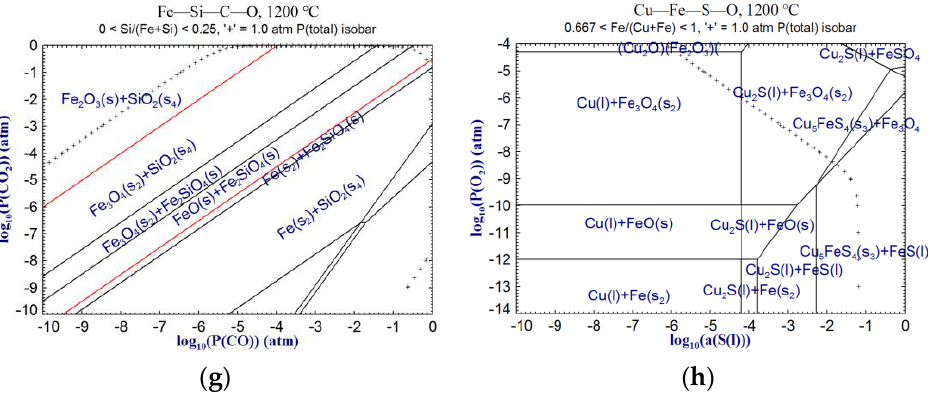
( g ) ( h ) Figure 4. Advantageous area maps (1200 °C) of oxides and sulfides in copper slag ( a ): Fe － Cu － C Figure 4. Advantageous area maps (1200 ◦ C) of oxides and sulfides in copper slag ( a ): Fe—Cu—C—O, － O, ( b ): Fe － Zn － C － O, ( c ): Fe － Pb － C － O, ( d ): Fe － Mg － C － O, ( e ): Fe － Al － C － O, ( f ): Fe － Ca ( b ): Fe—Zn—C—O, ( c ): Fe—Pb—C—O, ( d ): Fe—Mg—C—O, ( e ): Fe—Al—C—O, ( f ): Fe—Ca—C—O, － C － O, ( g ): Fe － Si － C － O, ( h ): Cu － Fe － S － O. ( g ): Fe—Si—C—O, ( h ):